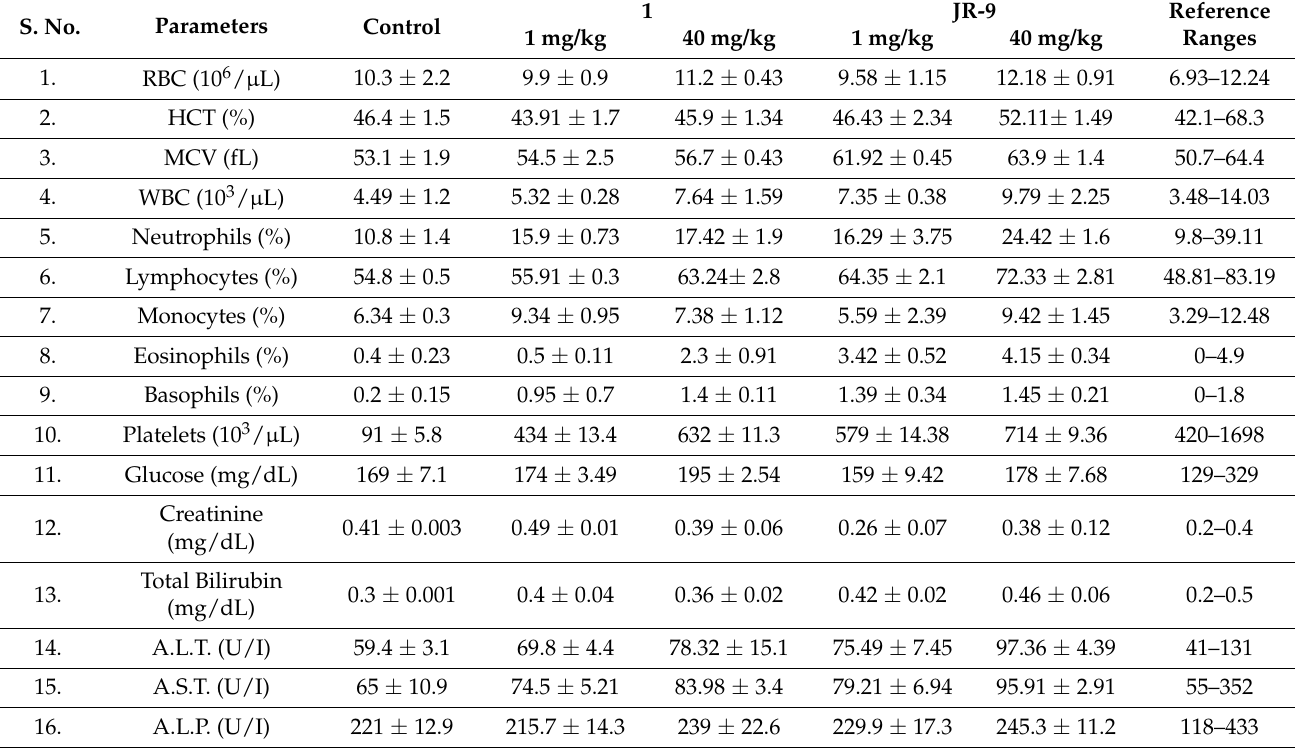
Table 4. Effect of 1 and JR-9 on biochemical and hematological parameters in Female BALB/c mice. Values are expressed as mean ± SD for five female mice in each group. RBC: red blood count; HCT: hematocrit; MCV: mean corpuscular volume; WBC: white blood cells; ALT: alanine aminotransferase; AST: aspartate aminotransferase; ALP: alkaline